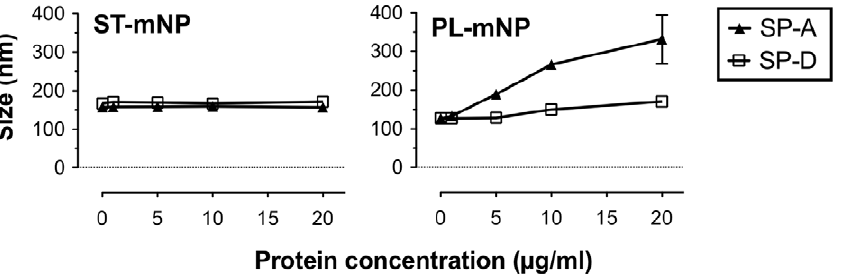
Figure 4. Influence of SP-A or SP-D on colloidal stability of nanoparticles. Increasing concentration of SP-A or SP-D were added to Starch- modified magnetite nanoparticles (ST-mNP; left) or Phosphatidylcholine-modified mNPs (PL-mNP; right). Hydrodynamic diameter (Z-average, size in nm) was determined subsequently after mixing using dynamic light scattering. Data shown as mean 6 SD (n=6).